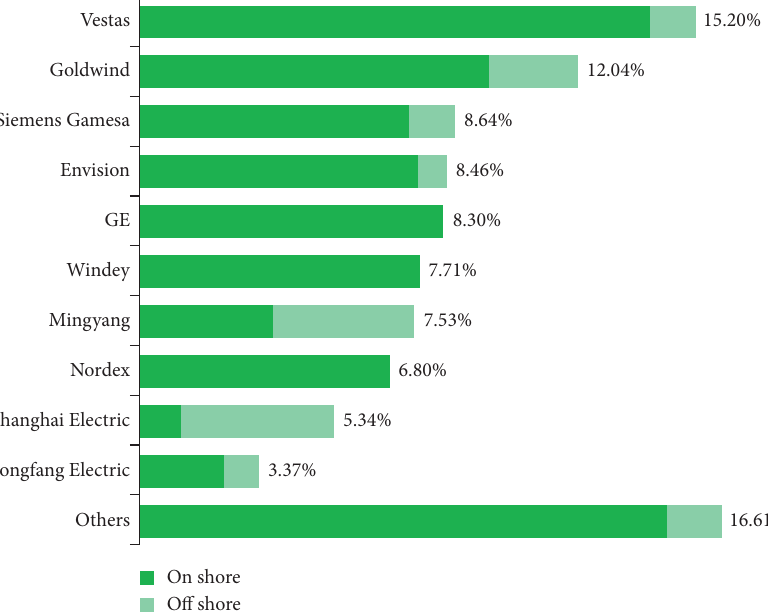
Figure 1: Top ten global WS markets, including on- and ofshore sorts. Table 2: Fault types and their % happening [38]. Fault